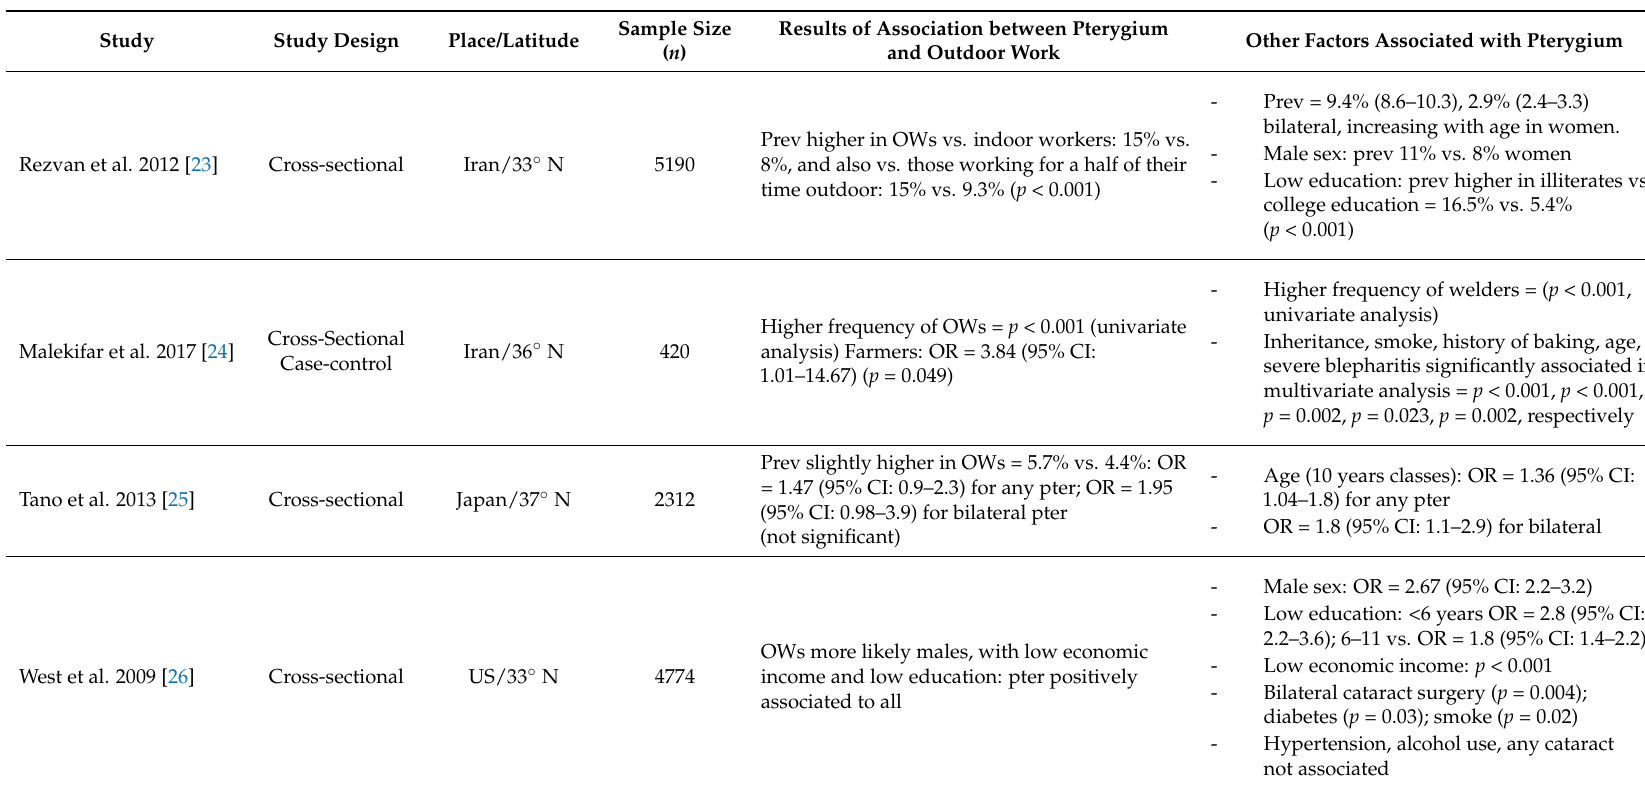
Table 3. Synthesis of the studies on occupational solar UV radiation exposure and pterygium included in the systematic review of scientific literature published in the period 2008–2017 performed in World areas at high risk considering the mean annual UV index